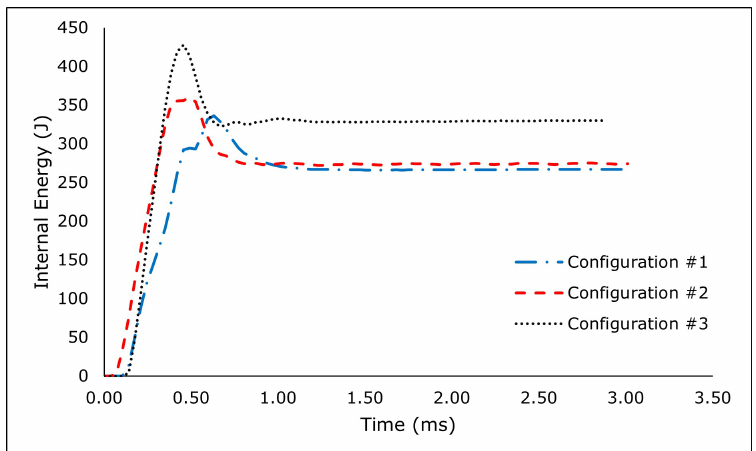
Figure 17. Internal Energy Change of The Lattice Structure.